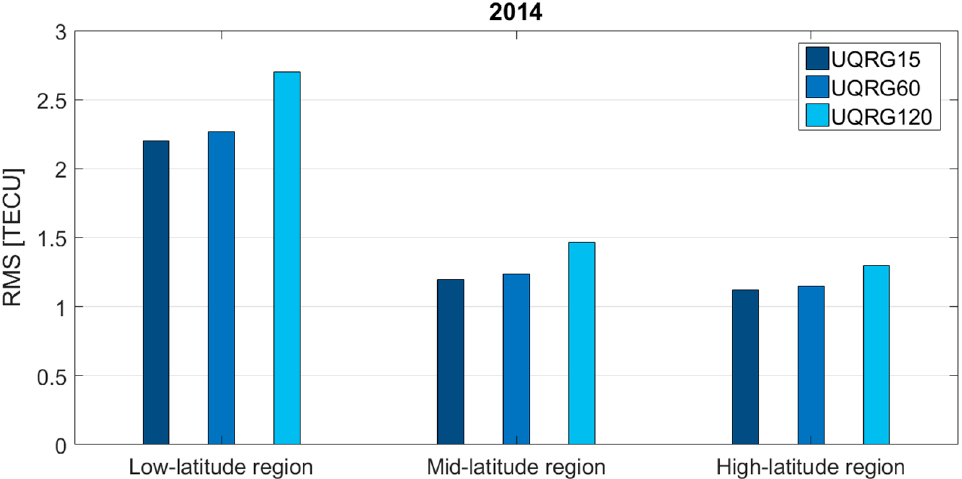
Figure 7. Annual RMS from GNSS-STEC comparisons for all analyzed GIMs over selected geomag- netic regions in 2014. netic regions in